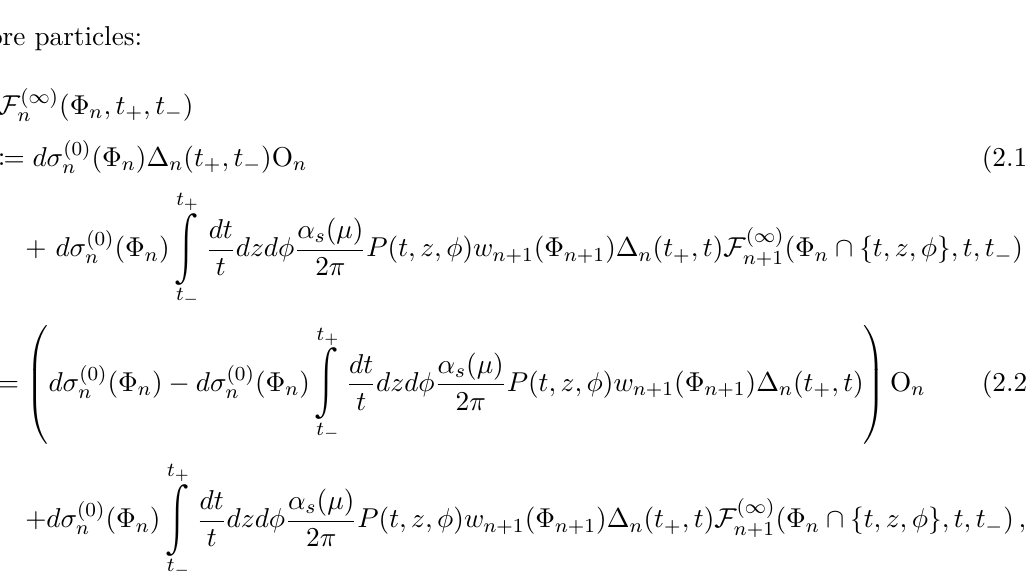
Figure 1 . Reference for the sub- and superscript notation used in this